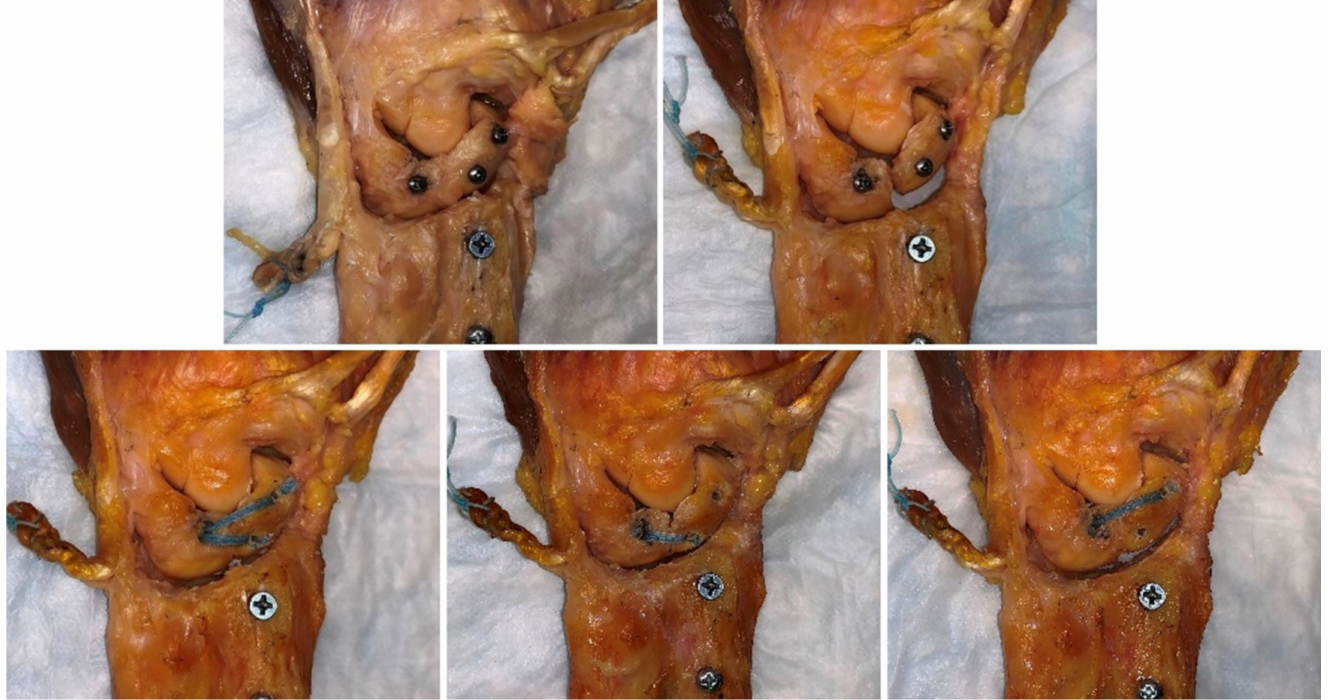
Figure 4. There were five testing states in this experiment: with the SLIL intact, after scapholunate dissociation (all SLIL and the radioscaphocapitate ligament cut off), and after the three different reconstructions. Regarding the order of reconstruction, Combo IB was performed first, and subsequently, long-oblique IB and short-transverse IB were randomly selected. SLIL, scapholunate interosseous